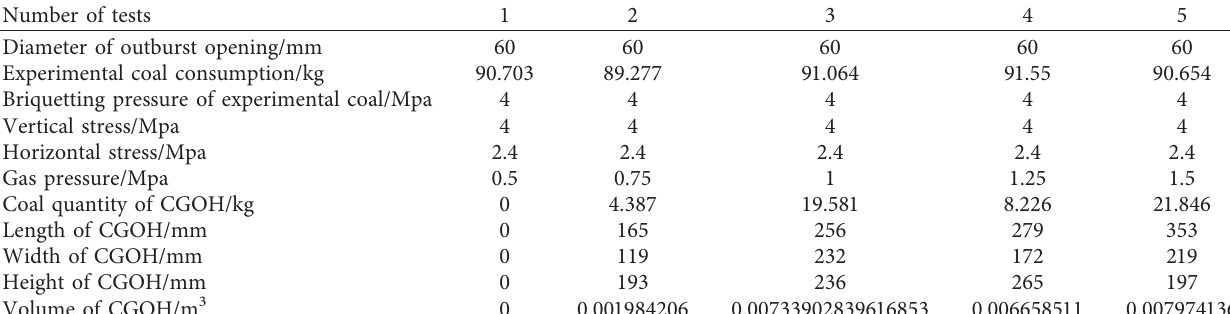
Table 7: Experimental statistics of gas pressure and volume of CGOH.